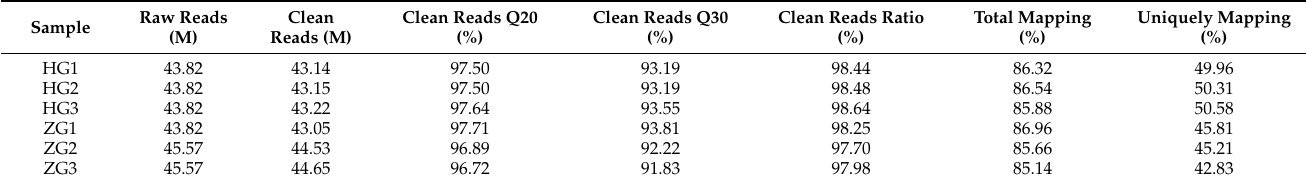
Table 1. The basic statistics for RNA-seq reads were generated from the livers of Hu sheep and Tibetan sheep. Raw Reads Sample